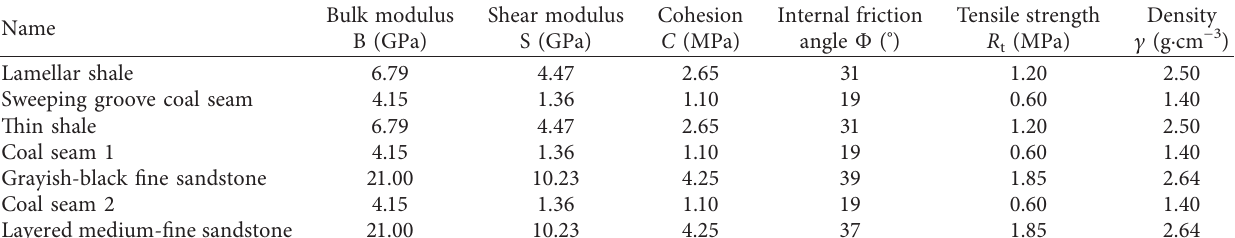
Table 1: Mechanics calculation parameters of strata.